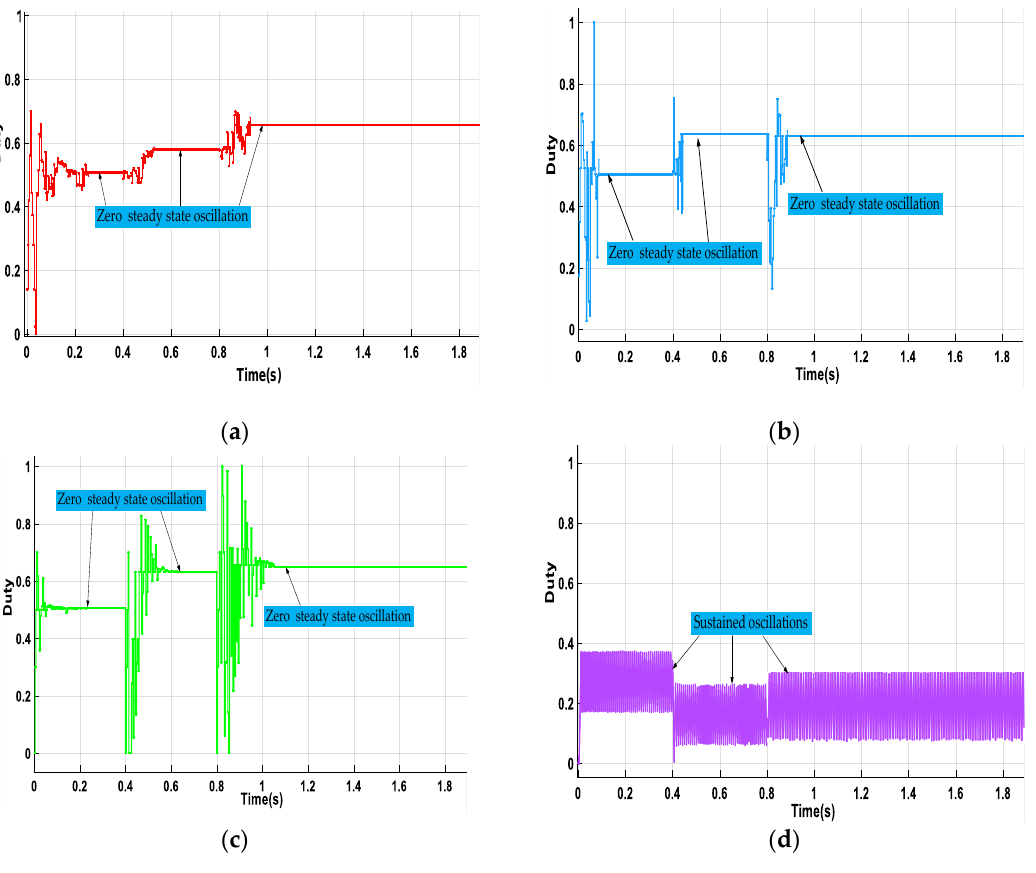
Figure 12. The obtained duty cycle by the algorithms over the step changes from pattern 3 and pattern 4. ( a ) TSO; ( b ) ITSO; ( c ) CS; ( d ) INC.